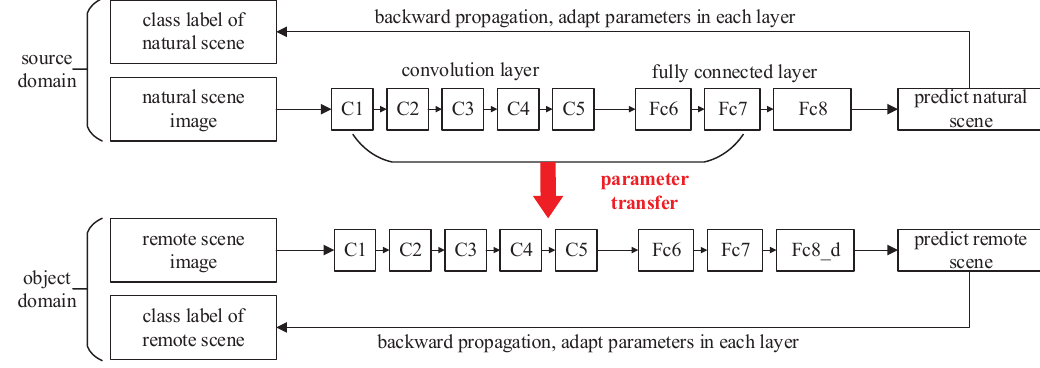
Figure 16. The transfer learning flowchart of the sceNet